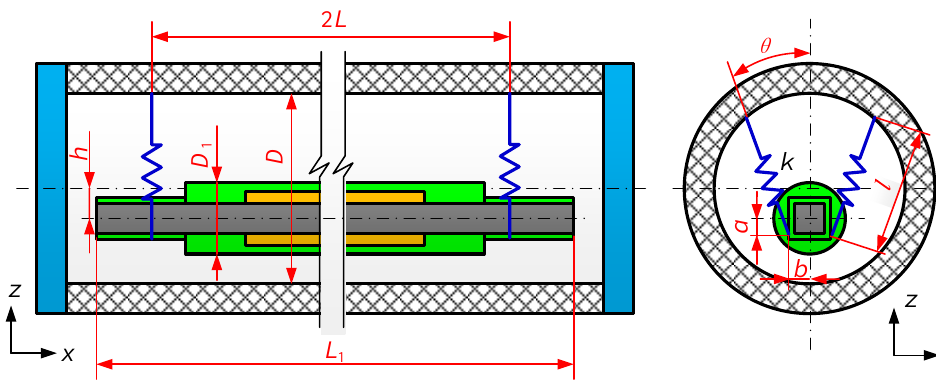
Figure 2. Structure and dimension diagram of the antenna and its damping system. Table 2. The structure and mechanical parameters of the antenna and its damping system.